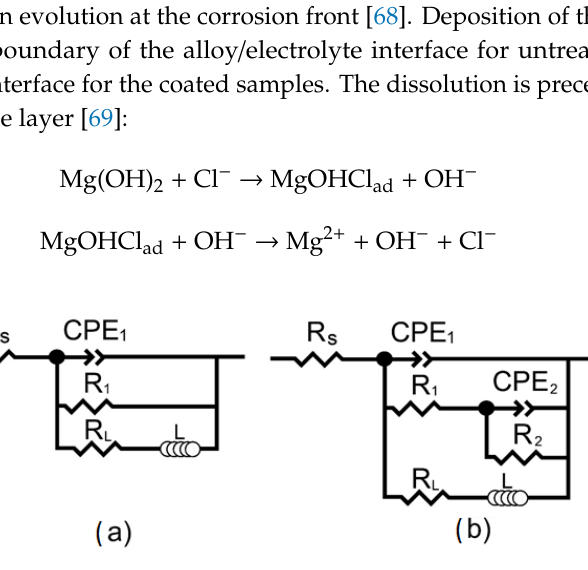
Figure 13. Equivalent electrical circuits (EECs) used for modelling the impedance spectra for: ( a ) bare Mg0.8Ca and ( b ) coated samples. Table 3. Calculated parameters of the EECs elements *.